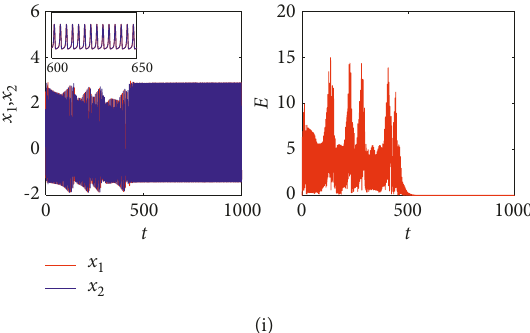
Figure 18: The time series of membrane potentials x (red line) and x (blue line), and error functions of the coupled model at case 6 1 2 (periodical and bursting neurons). For (a) periodical firing synchronization with τ � 0 . 01 and D � 2; (b) bursting firing synchronization with τ � 0 . 01 and D � 15; (c) bursting firing synchronization with τ � 0 . 1 and D � 3; (d) spiking firing synchronization with τ � 0 . 1 and D � 7 . 5; (e) quiescent state synchronization with τ � 0 . 1 and D � 9; (f) spiking firing synchronization with τ � 0 . 3 and D � 3; (g) quiescent state synchronization with τ � 0 . 3 and D � 4; (h) quiescent state synchronization with τ � 0 . 5 and D � 5; and (i) periodical firing synchronization with τ � 3 and D � 4. The initial values are selected with (0.1, 0.01, 1.05, 0.1, 0.01, 1.05).